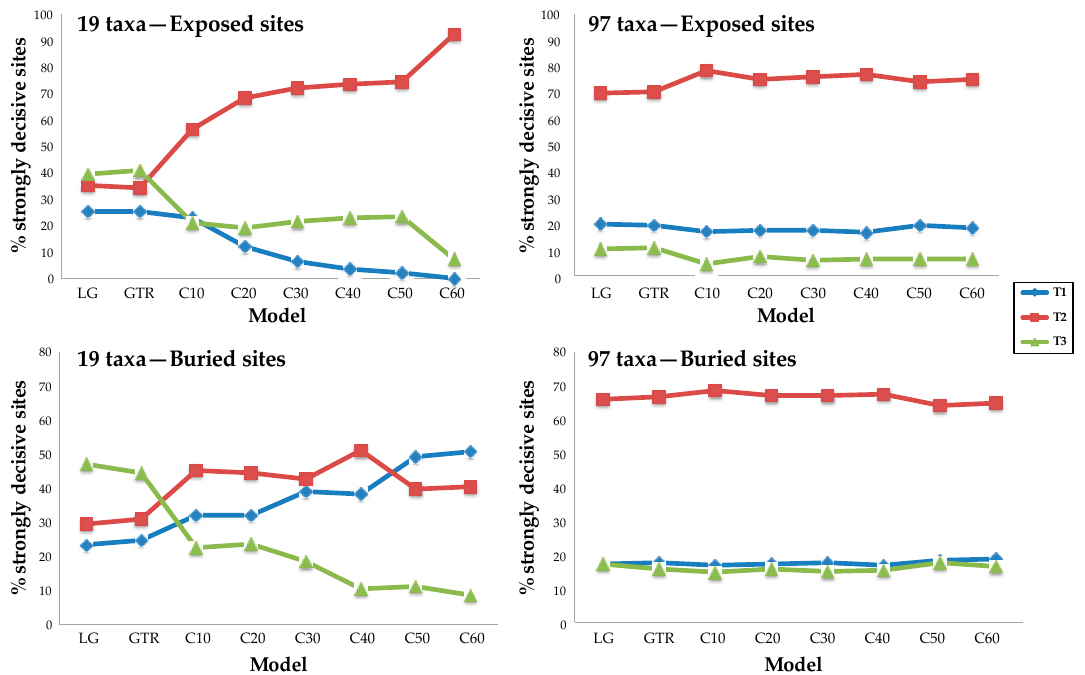
Figure 4. Proportions of strongly decisive sites supporting each topology are stable with respect to model complexity when a rich taxon sample is analyzed. A pair of 25,000-site datasets was chosen to explore the impact of increasing model complexity and adding taxa. The results of analyses using sparse taxon samples (left) were unstable to increasing model complexity, shifting from T3 to T2 for exposed sites and from T3 to T2 and finally to T1 in the case of the buried site sample. The results of analyses using the 97-taxon dataset were robust to changes in model complexity. We observed similar results for the data subsets defined using SS (Supplementary Figure S3).